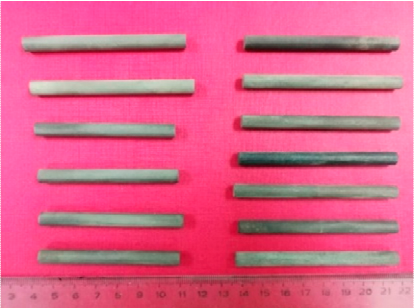
Figure 3. Part of specimens after the uniaxial tensile experiment.